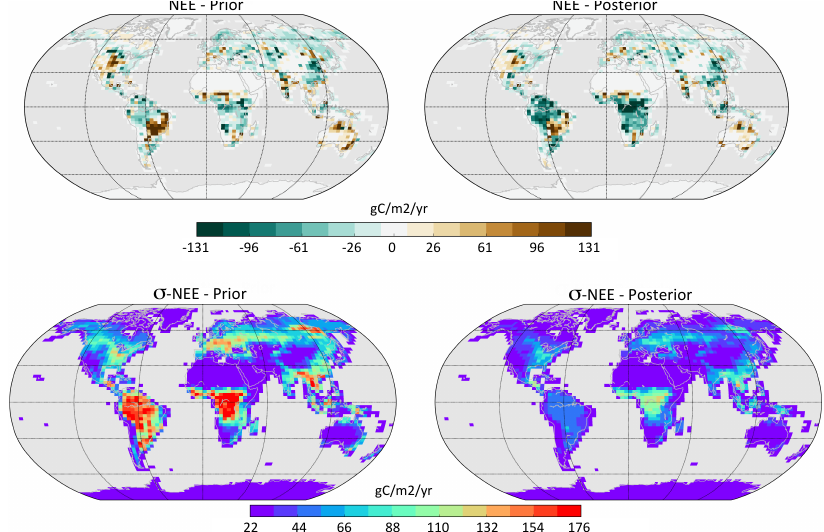
Figure 11. Simulated annual net carbon exchange (NEE) for the land ecosystems prior to any optimization (left column) and after step 3 of the optimization process (right column). Upper figures correspond to the mean NEE (in gCm − 2 yr − 1 ) over the assimilation period (2001– 2003) and lower figures to the associated monthly flux uncertainties (averaged over the whole period and expressed in gCm − 2 yr − 1 ) due to the parameter uncertainties (see text).